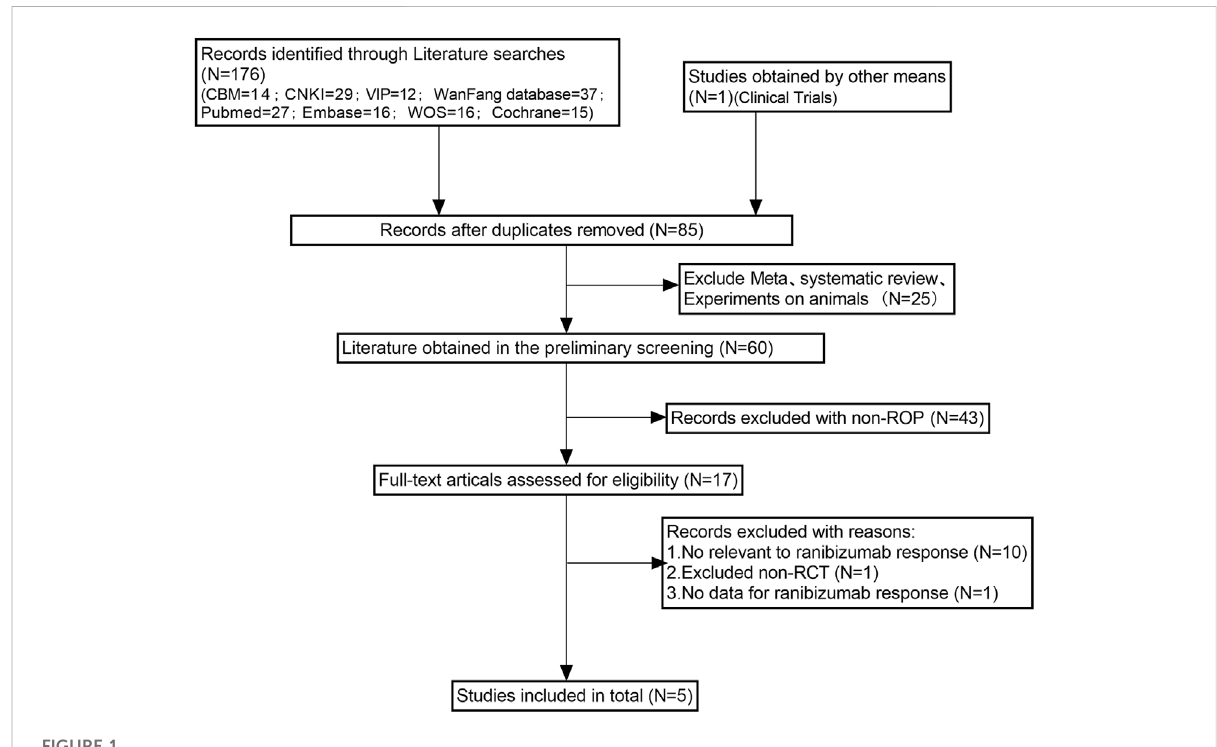
FIGURE 1 Literature screening process and